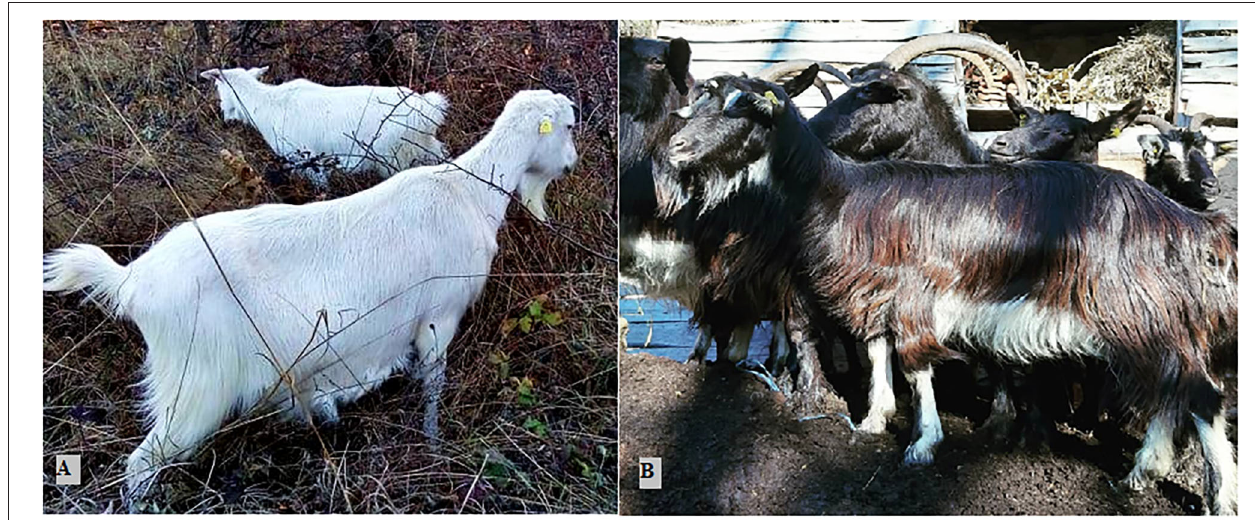
FIGURE 1 | Serbian white (A) and Balkan goat (B)